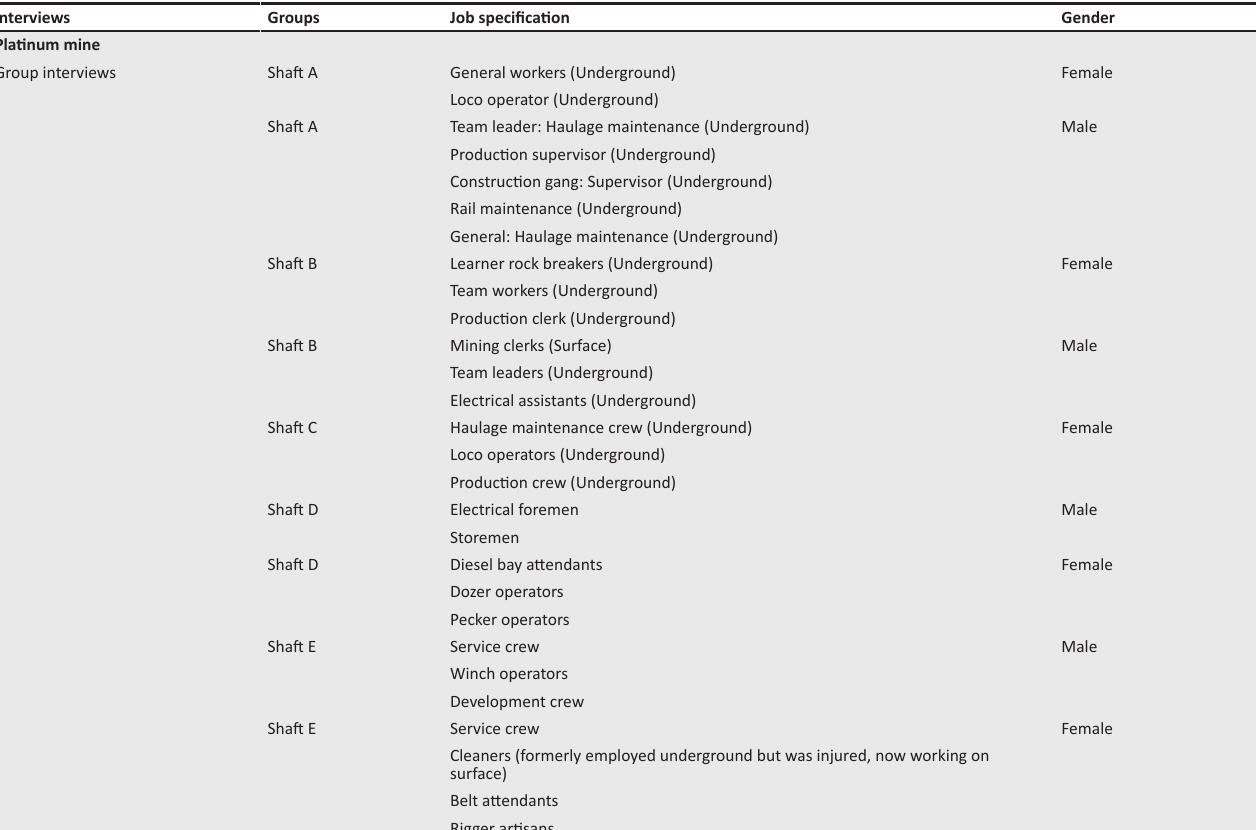
TABLE 2 (Continues...): Individual and group interviews conducted at the